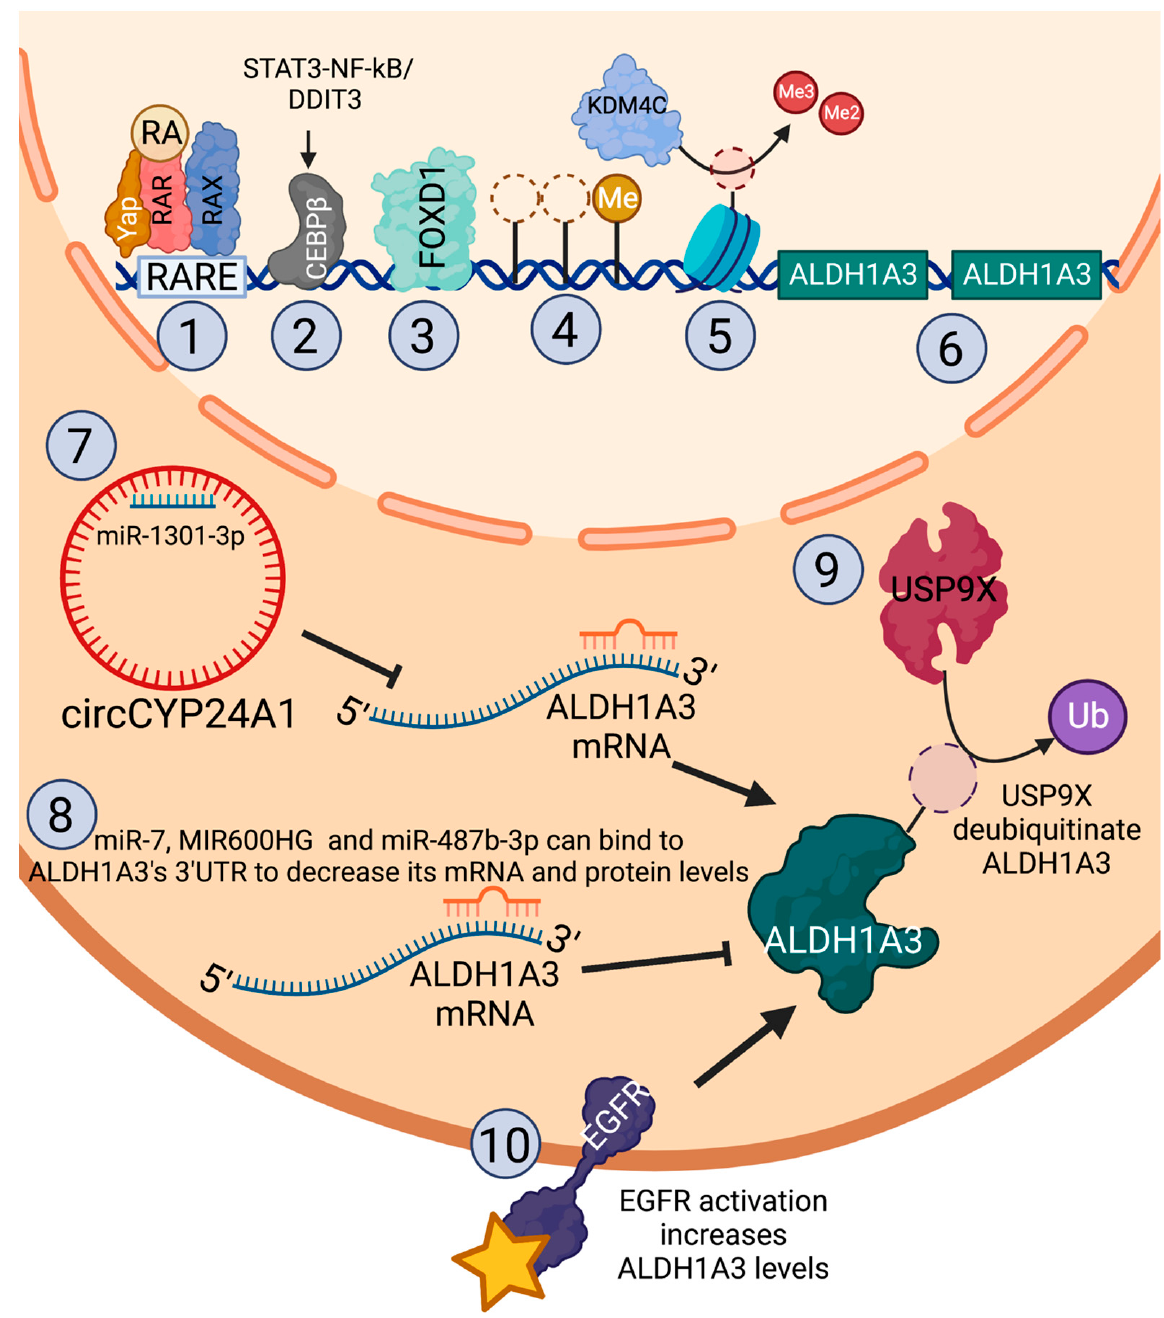
Figure 2. Mechanisms of regulation of ALDH1A3 in cancer. ALDH1A3 is transcriptionally regulated by (1) Yap-activated RAR-RXR [67], and (2) transcription factors CEBP β [69], (3) FOXD1 [81].